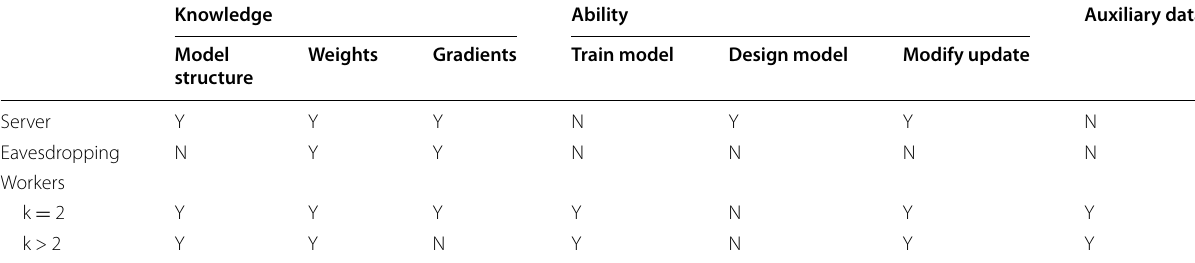
Table 1 Threat model of privacy inference attacks in the training phase, Y (Yes), N (No)